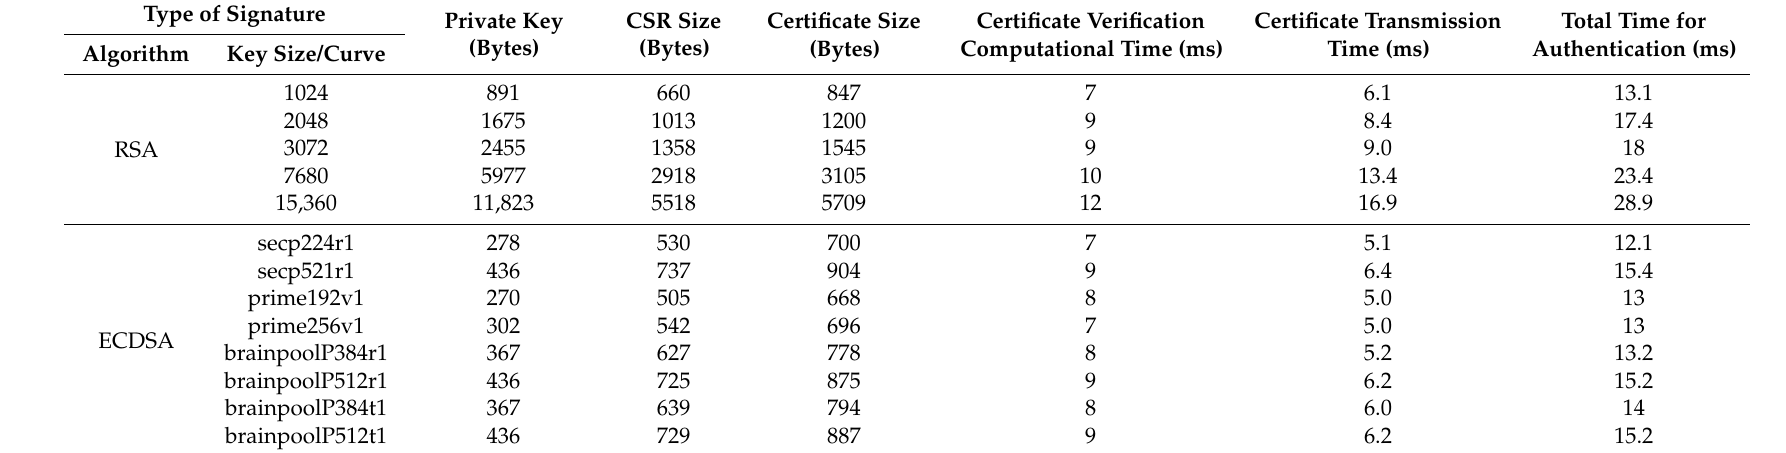
Table 2. Computational times for explicit certificate verification with different key sizes of RSA and ECDSA.